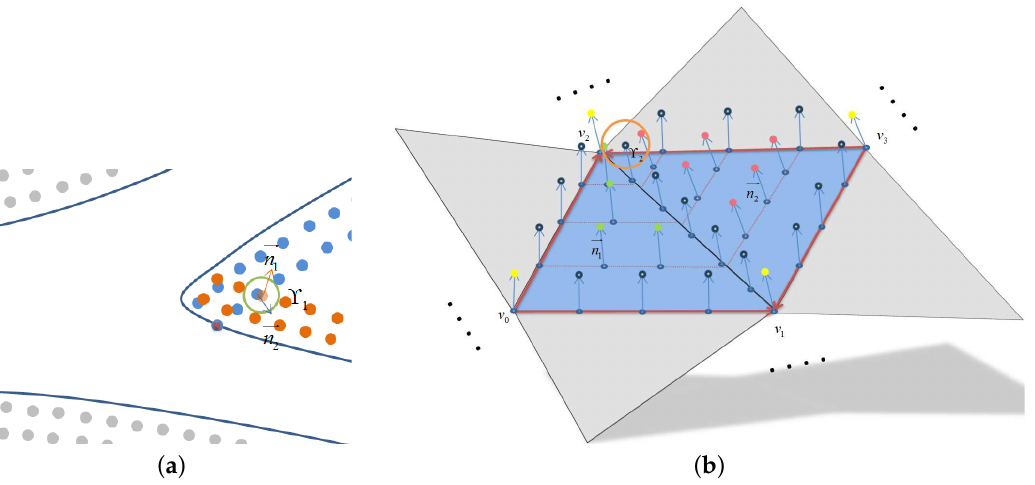
Figure 4. The dense region of extrapolated boundary particles. ( a ) A bifurcation region; ( b ) Neighbor triangle regions